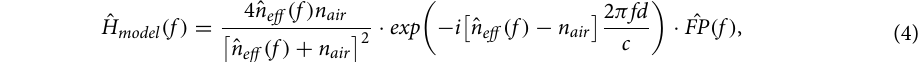
calculations based on the transfer matrix method 22 . The value of ˆ n eff is corrected after each step of the iterative algorithm. The modeled transfer function is determined as